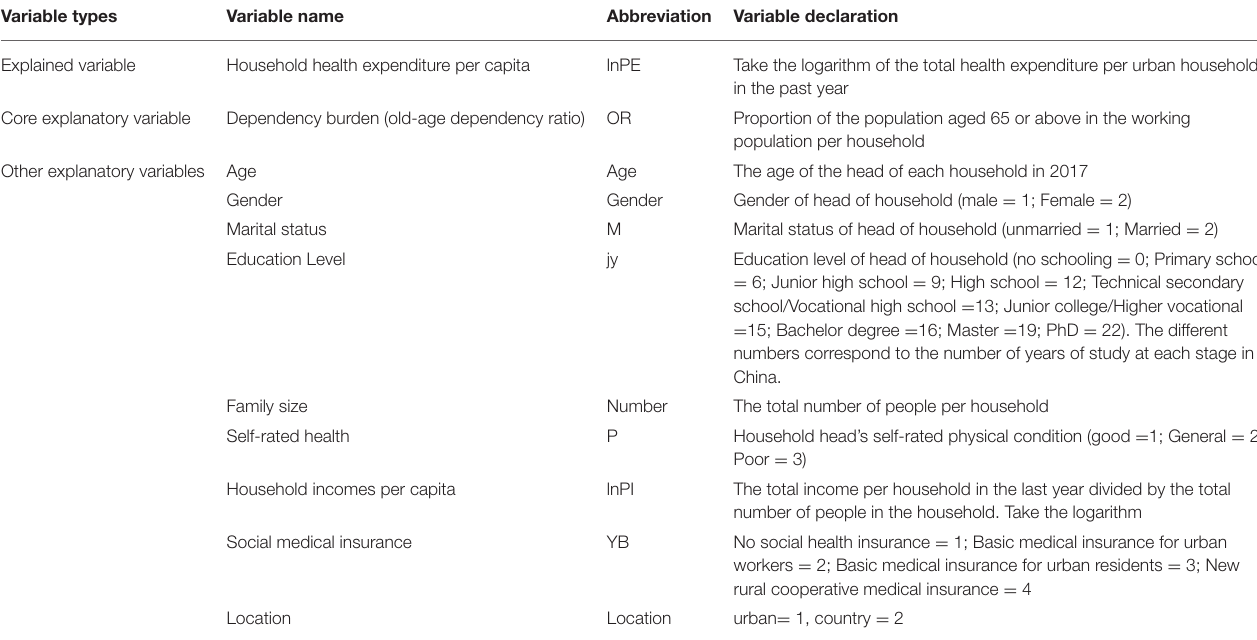
TABLE 1 | Description of each